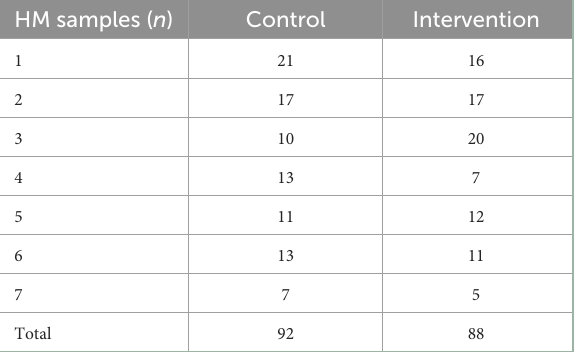
TABLE 3 Number of longitudinal human milk (HM) samples collected in New Zealand during 12 months of lactation. HM samples ( n )